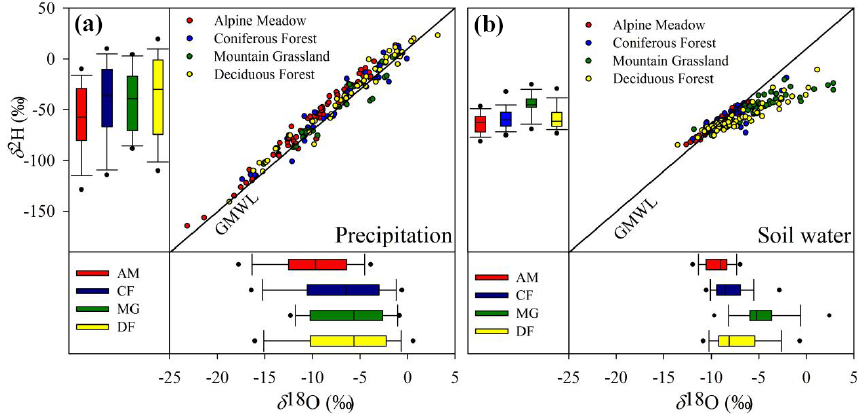
Figure 5. Dual-isotope space of precipitation (a) and soil water (b) in isotope data of four vegetation zones. In the box plots, the box represents the 25th–75th percentile, the line in the box represents the median (50th percentile), the required line indicates 90th and 10th percentile, and the point indicates the 95th and 5th